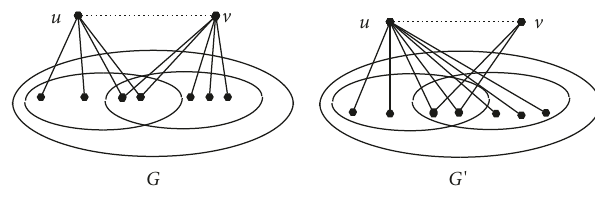
Figure 1: The Kelmans transformation.